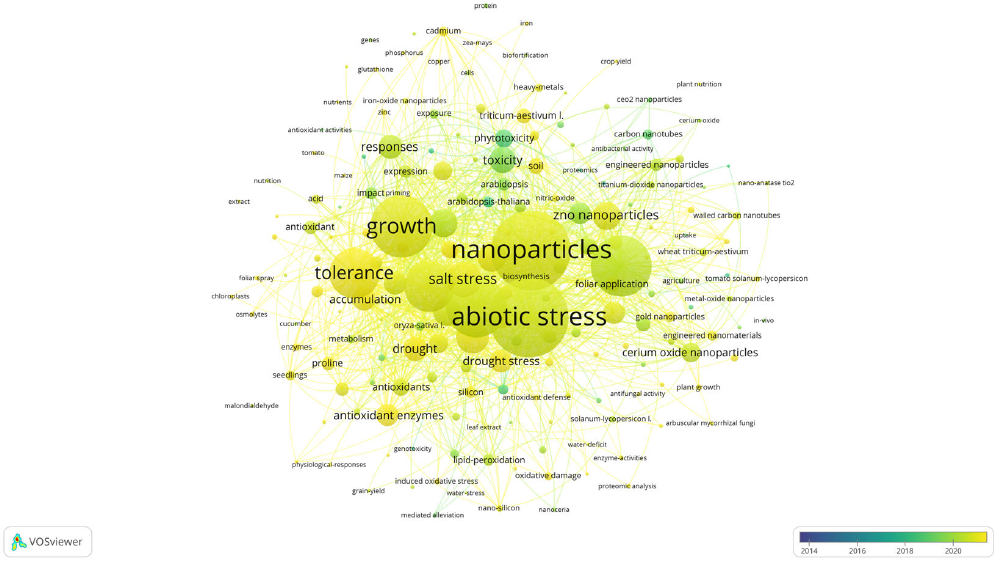
Figure 6. The main keywords of network co ‐ occurrence.